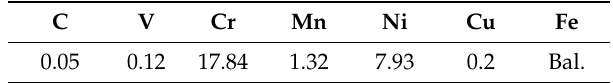
Table 1. Compositions of the 304 stainless steel used (wt.%).